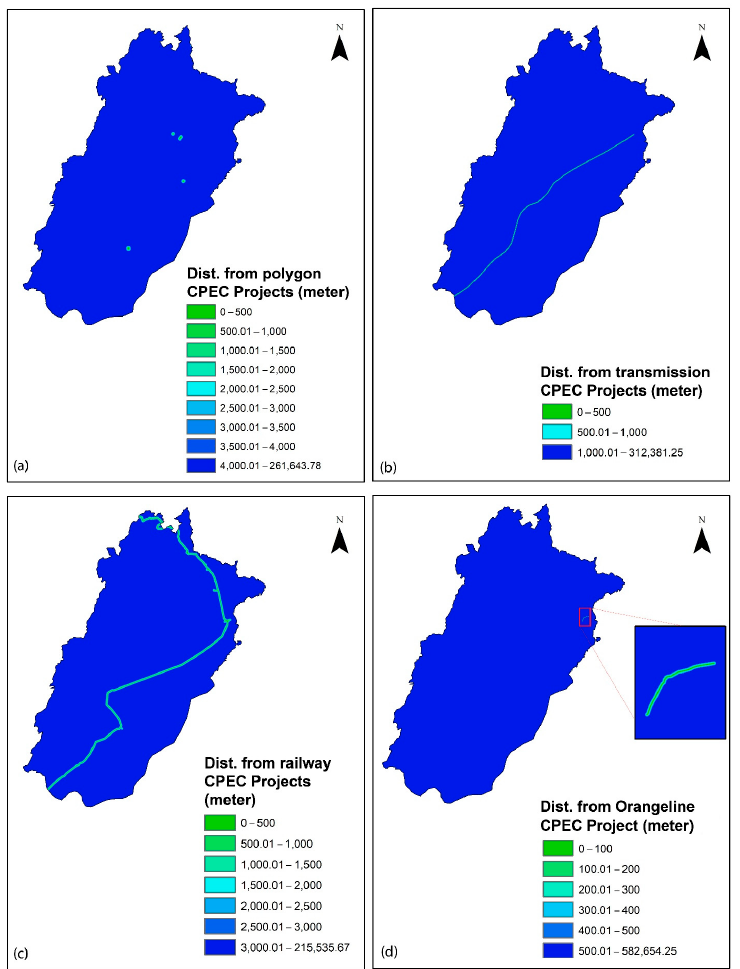
Figure A6. Maps of indicators belonging to CPEC projects group (G6): ( a ) distance from polygon CPEC projects; ( b ) distance from transmission CPEC project; ( c ) distance from railway CPEC projects; ( d ) distance from Orangeline CPEC project.